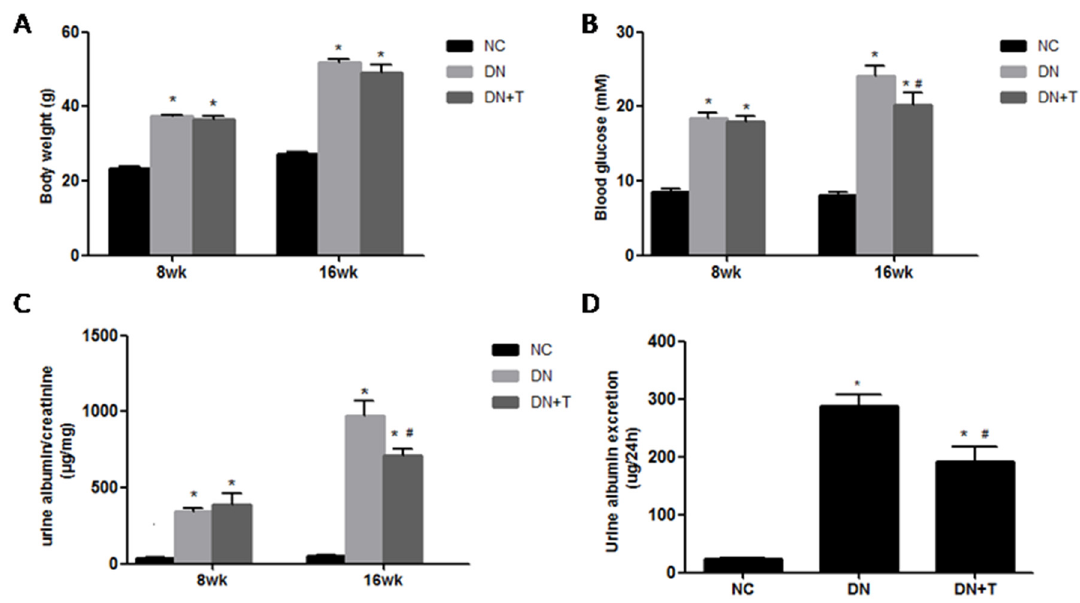
Figure 1. Physical and biochemical characteristics in various groups of mice. The DN + T group (db/db mice treated with TUDCA, n = 10) were administrated with 250 mg/kg TUDCA twice a day by i.p. injection for eight weeks. Mice in the NC group (normal control db/m mice, n = 10) or DN group (diabetic db/db mice, n = 10) received the equal amount of normal saline. Body weight ( A ); blood glucose ( B ); the ratio of urinary albumin and creatinine ( C ); and urine albumin excretion ( D ) of db/db mice were decreased by TUDCA treatment. Results are shown as means ± SEM. * p < 0.05 versus NC group. # p < 0.05 versus DN group.